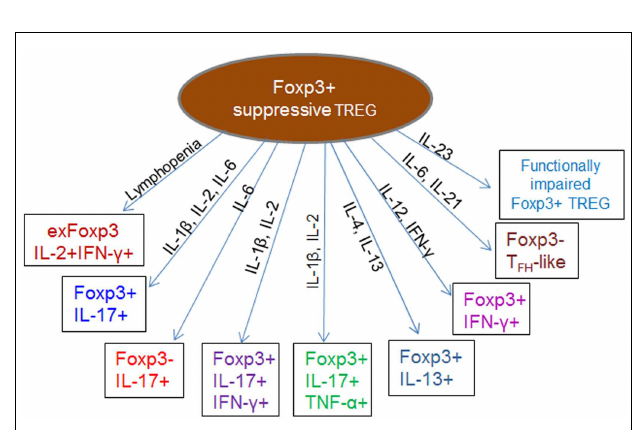
FIGURE 3 | Impaired or altered function of regulatory cells during inflammation .The cytokine and chemokine milieu of inflammatory micro-environments can induce phenotypic and functional modification in Treg, leading to generation of pathogenic exFoxp3T cells, which express lower levels of Foxp3, CTLA-4, and GITR and produce a combination ofTh1, Th2, orTh17 cytokines. Conversion of Foxp3 + Treg into pathogenic IFN- γ -producingTh1 cells or IL-17-producingTh17 exFoxp3Treg cells is documented in various immunological settings (77, 80, 101). Conversion to aTh2 phenotype expressing IL-13 (Foxp3 + IL-13 + ) and IL-5 (78, 83) as well as differentiation into follicular helperT cells (84) have also been reported. In most cases, the suppressive function of these altered phenotypes is significantly reduced due to decreased Foxp3 expression (81, 82). Certain inflammatory conditions can support the generation of hybrid phenotype Treg, which exhibit dual suppressive and pro-inflammatory functions such as the IL-17-producing Foxp3 + IL-17 + (85–90), IFN- γ -producing Foxp3 + IFN- γ + (91, 92), Foxp3 + IL-17 + IFN- γ + , or Foxp3 + IL-17 + TNF- α + (102, 103) Treg. Generally, environments enriched withTh1 cytokines such as IFN- γ , IL-2, and IL-12 favor generation of exFoxp3Treg producing IFN- γ ,